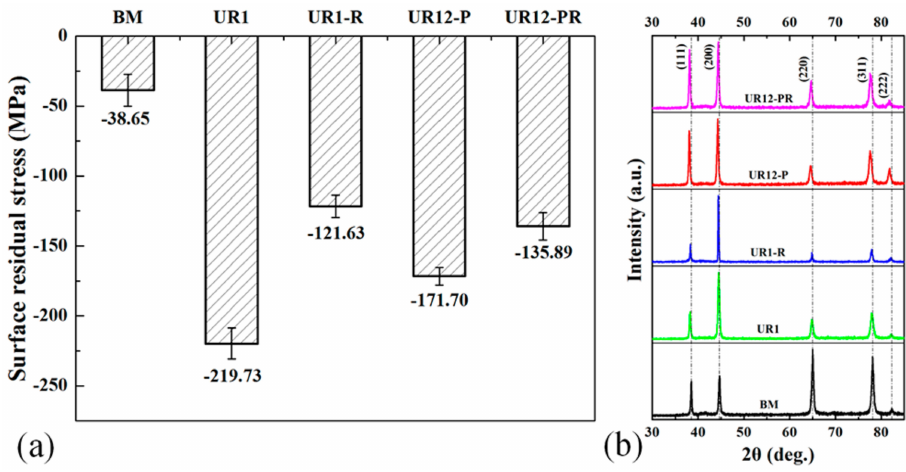
Figure 3. ( a ) Surface residual stress and ( b ) XRD patterns of di ff erent